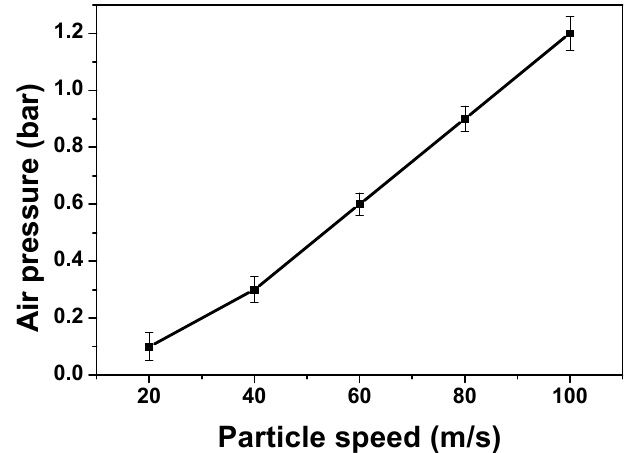
Figure 2. Air jet pressure vs. particle speed.